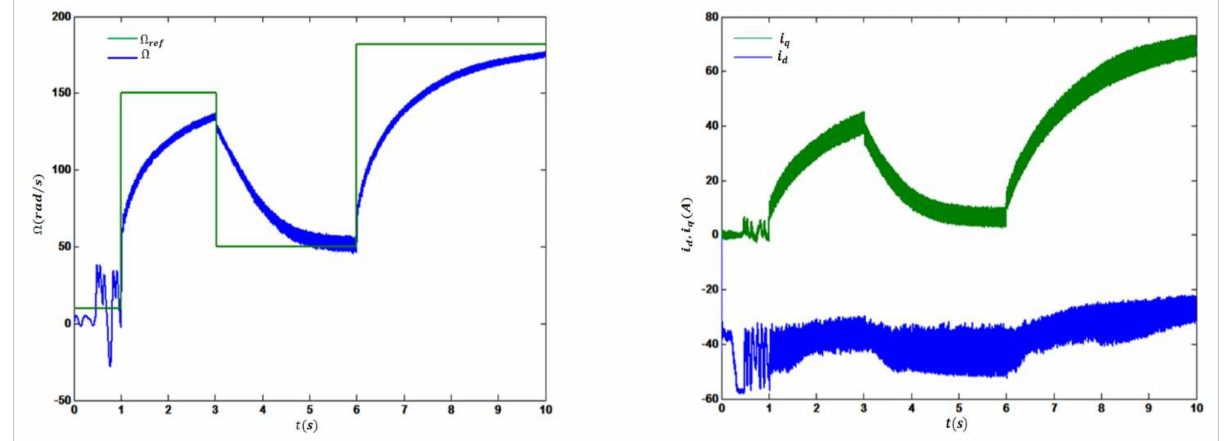
Figure 14. PMSM performance for low, middle and high reference speed for the maximum power operating point MPOP 2 , T = 25 ◦